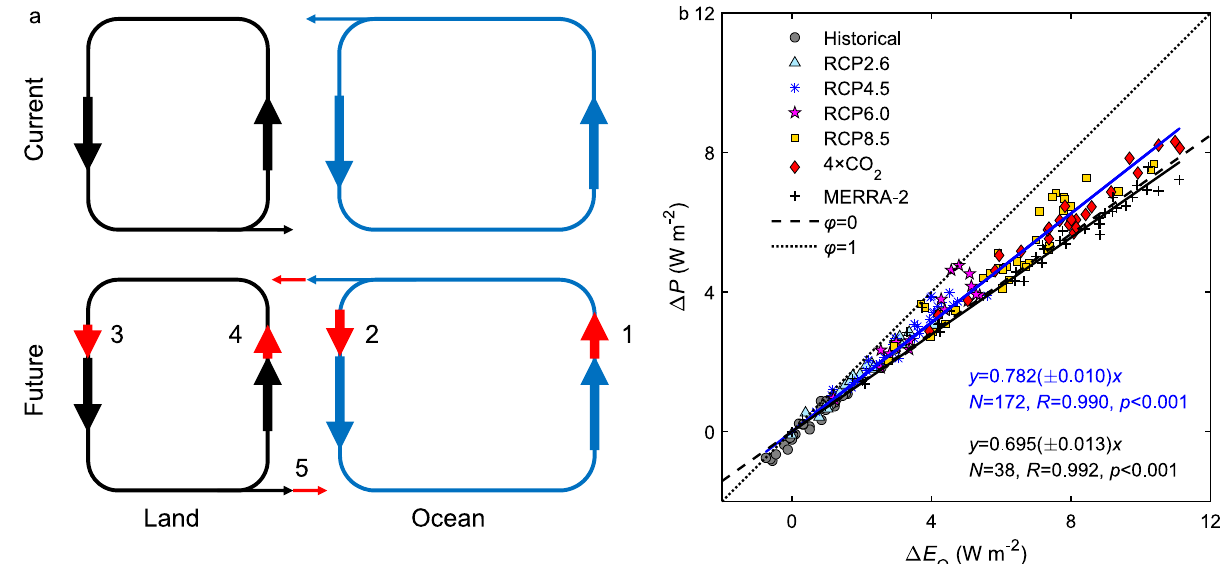
Fig. 1 Global precipitation change driven by ocean evaporation. a Two interlinked components of the global hydrological cycle. Arrows 1 to 5 represent changes in ocean evaporation, ocean precipitation, land precipitation, land evaporation, and runoff, respectively. b , Relationship between global precipitation change Δ P and ocean evaporation change Δ E O according to CMIP5 model simulations and MERRA-2 reanalysis. The black (reanalysis) and blue solid line (CMIP models) represent linear regression with statistics noted. The dashed and dotted lines represent the land modi fi er φ of 0 and 1. The CMIP results include historical climate (Historical), a low emission scenario (RCP2.6), two medium emission scenarios (RCP4.5 and RCP6.0), a high emission scenario (RCP8.5), and quadrupling of CO 2 experiments (4 × CO 2